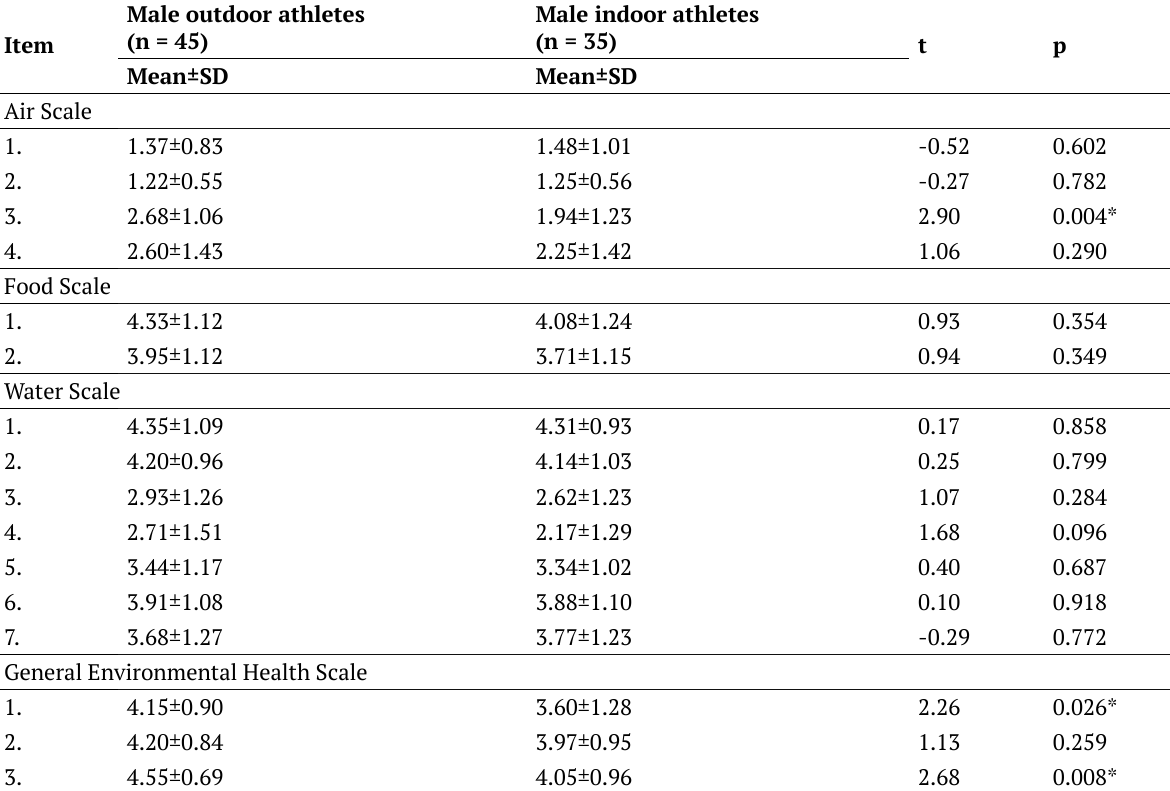
Table 3. Behaviour declared by male outdoor athletes and male indoor athletes within Environmental Health Literacy